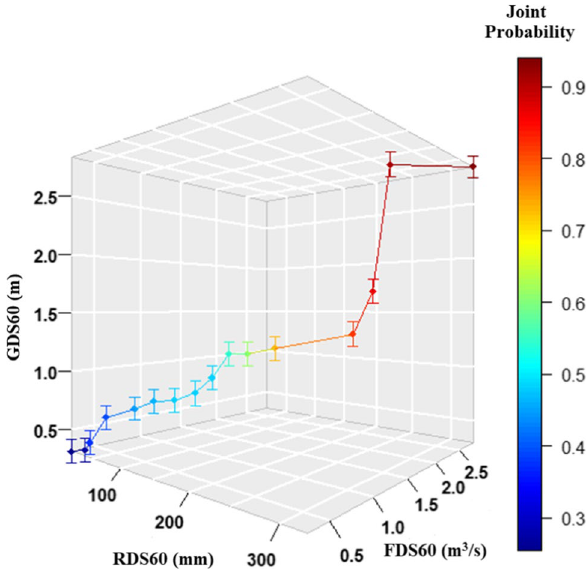
Fig. 12 Joint probability of occurrence of groundwater deficiency signature for a 60-day duration in Tapik